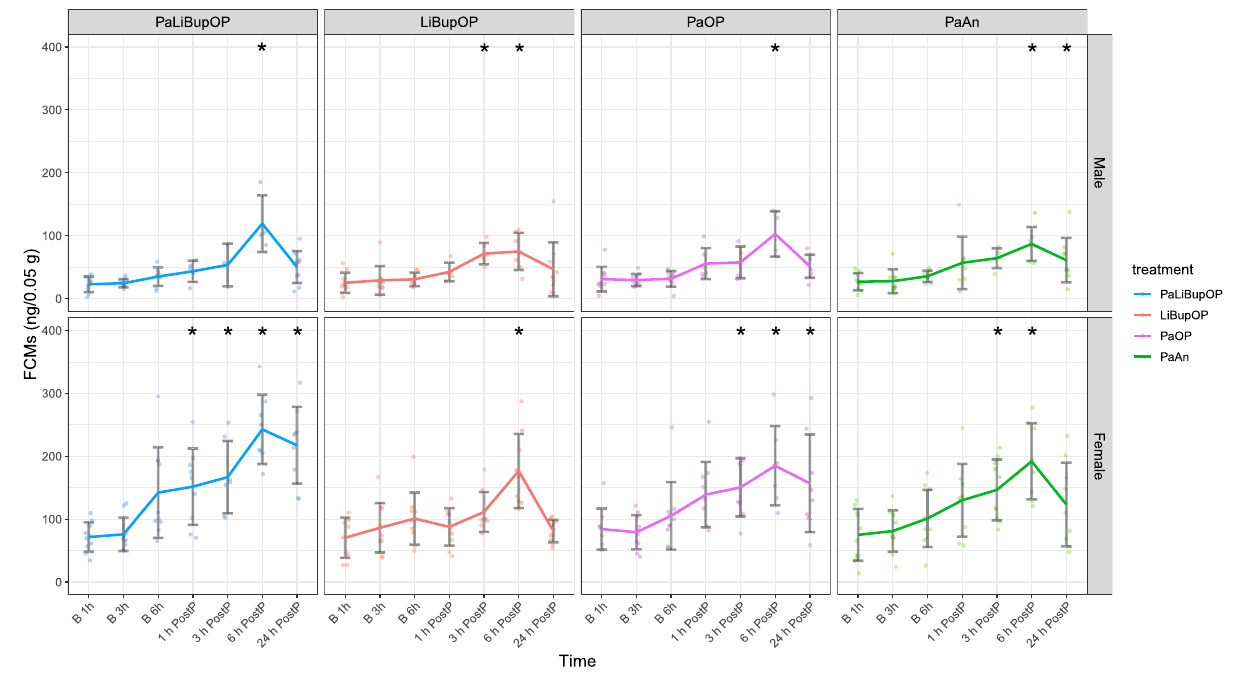
Figure 8. Fecal corticosterone metabolites (ng/0.05 g feces) in baseline and post-procedure phase for male and female mice in each treatment group. FCMs were measured at the respective baseline time points and 1, 3, 6, and 24 h after surgery or anesthesia. The number of animals from which samples could be collected is indicated as dots. This number is lower than the actual animal number in several cases as feces could not be obtained from all animals. Bonferroni post hoc analysis detected no significant differences between the treatment groups at the baseline level. Male PaLiBupOP had a significantly higher FCM concentration than LiBupOP 6 h after surgery. In female animals, PaLiBupOP showed significantly higher FCM levels than LiBupOP 1, 6, and 24 h after surgery. At 24 h after surgery or anesthesia, female PaLiBupOP had significantly higher FCM levels than PaOP and PaAn, while FCM concentrations in LiBupOP were significantly lower than in PaOP. Significant differences to the respective baseline measurements are indicated with *p ≤ 0.05. Data are shown as scatter dot plot with mean ± SD. Numbers per group: PaLiBupOP, LiBupOP, PaOP, and PaAn n = 10/per